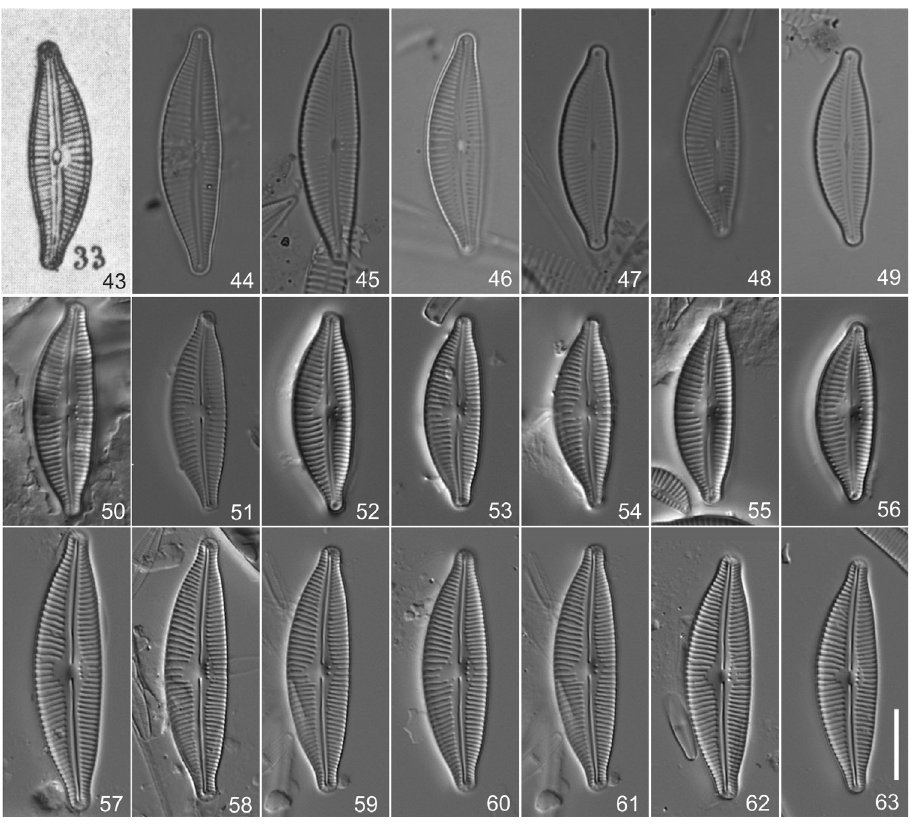
Figures 43–63. Cymbella tumidula species complex 43 Original illustration provided by Grunow in Schmidt (1875, Pl. 9, Fig. 33), lectotype, here designated 44–49 C. tumidula var. tumidula , specimens from Trieste in preparation BM 18543 49 Epitype, here designated 50–56 C. tumidula var.